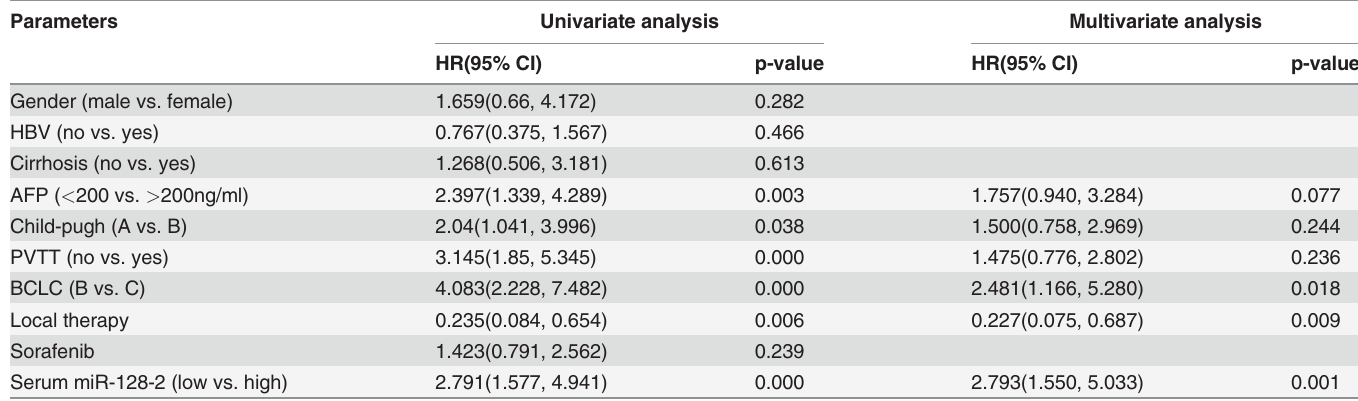
Table 4. Univariate and multivariate Cox regression analyses of parameters associated with overall survival of all HCC patients.